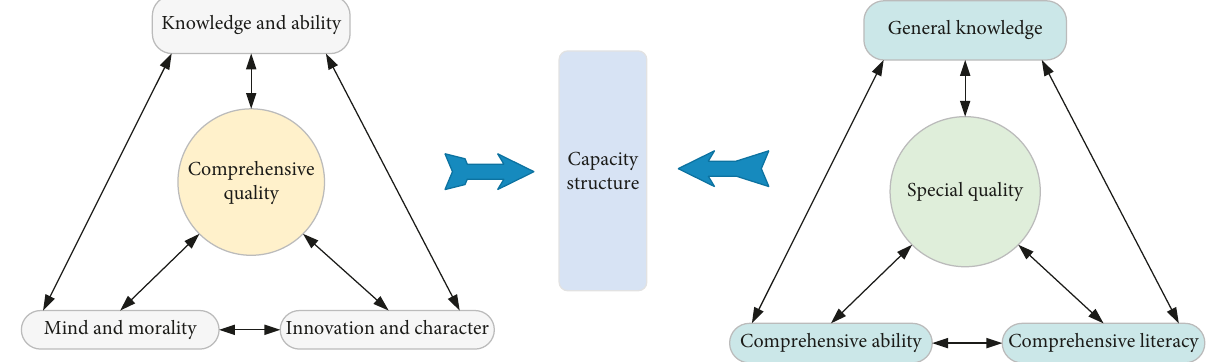
Figure 2: Ability of students majoring in international